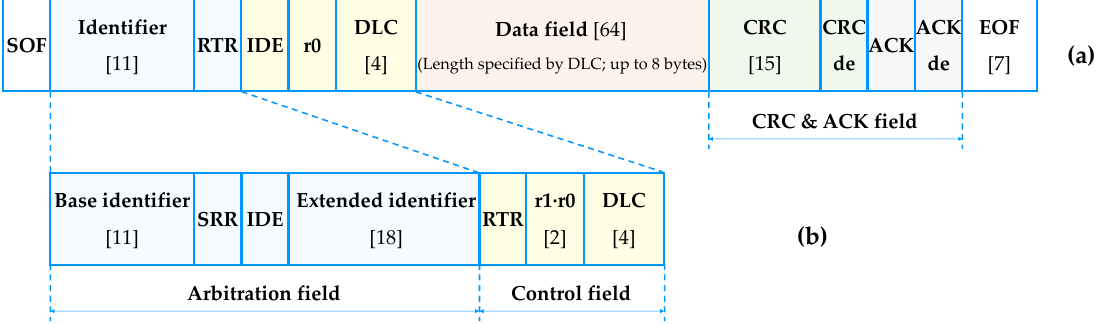
Figure 1. Controller area network (CAN) message structures: ( a ) base format; and ( b ) extended